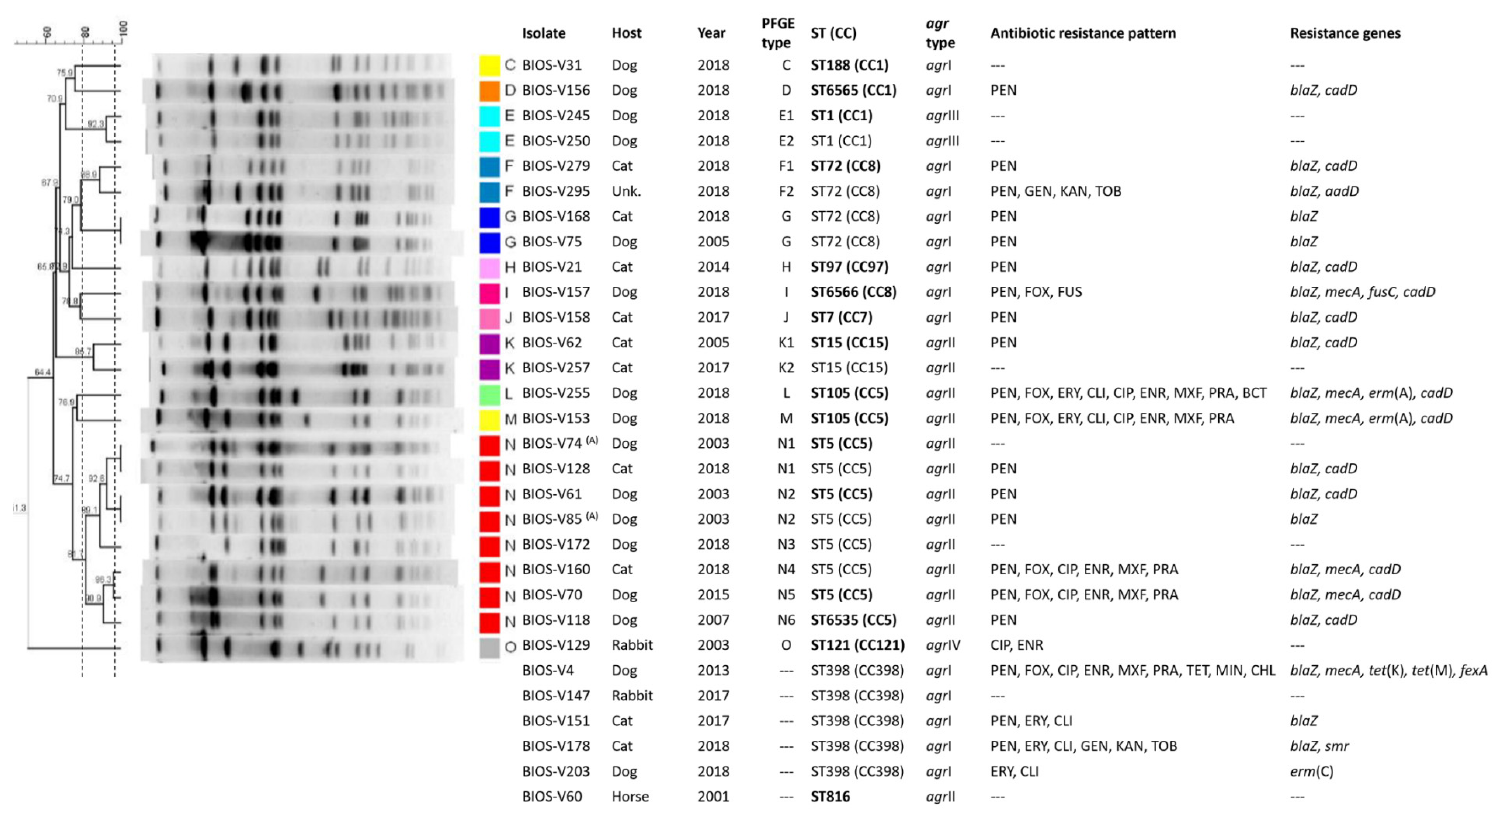
Figure 2. Sma I-PFGE profiles of the S. aureus isolates associated with SSTIs in companion animals and corresponding clonal lineages as determined by MLST and their correlation with host, agr types, phenotypic and genotypic resistance traits. The pairs of isolates recovered from the same animal are marked by (A) to (D), where each letter corresponds to a different animal. The dendrogram was built using Bionumerics and the UPGMA algorithm, using the Dice coefficient, an optimization of 0.5% and a tolerance of band of 1%. The dashed lines correspond to the similarity criteria for considering isolates belonging to the same PFGE type ( ≥ 80%) or subtype ( ≥ 97%). Isolates sharing the same PFGE type or subtype were considered as belonging to the same sequence type (ST). The isolates subjected to MLST are indicated in bold type. Unk: unknown host; CC: clonal complex; ST: sequence type; PFGE: pulsed-field gel electrophoresis; PEN: penicillin; CXI: cefoxitin; ERY: erythromycin; CLI: clindamycin; CIP: ciprofloxacin; ENR: enrofloxacin; MOX: moxifloxacin; PRA: pradofloxacin; KAN: kanamycin; GEN: gentamycin; TOB: tobramycin; FUS: fusidic acid; BCT: bacitracin.